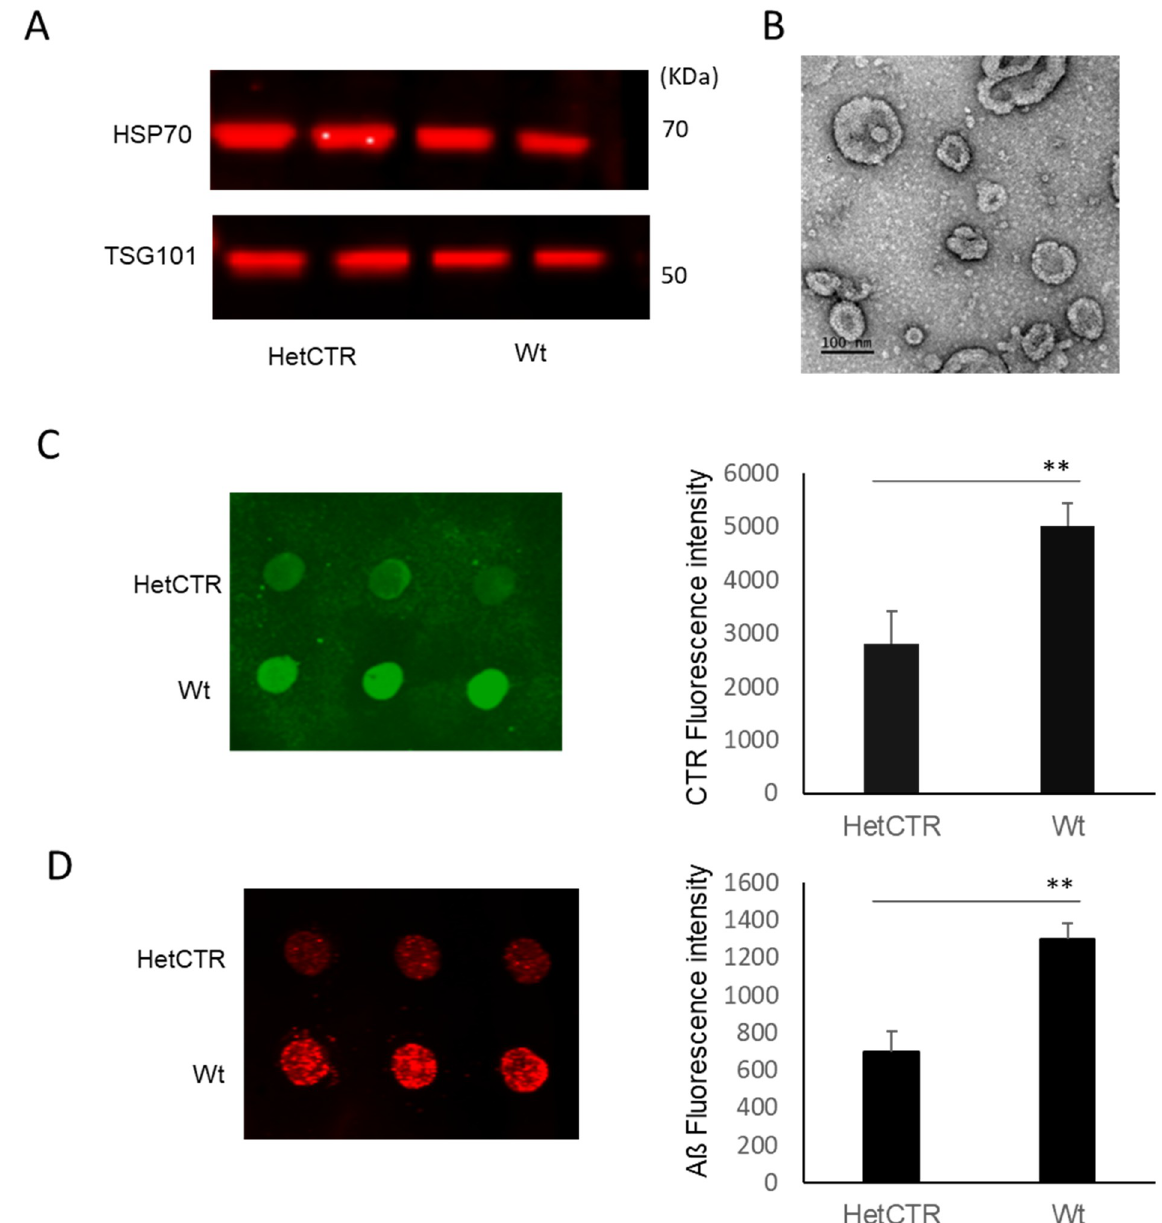
Fig 5. EVs from heterozygous AMY/calcitonin receptor (HetCTR) depleted mice and A β binding. A , Characterization of EVs from age- matched HetCTR mice brains and Wt mice using Western blot detection of EV markers, Hsp70, and TSG101. B , Transmission electron microscopy of EVs from brain of HetCTR mouse brain using a negative staining method. EVs appear as closed vesicles of 30–200 nm in diameter (Scale bar = 100 nm). C , Dot blot (left panel) showing greater abundance of CTR protein from EVs extracted from Wt mice compared to those from HetCTR mice. Histogram (right panel) showing the quantification of CTR from dot blots (Data presented as mean ± SEM, n = 5 mice each group. �� p < 0.01. D , Dot blots (left) and histograms (right) demonstrating increased A β binding to EVs from Wt mice compared to HetCTR mice following 30 min incubation the peptide. (A β levels are presented as the mean ± SEM, n = 5 mice each group, �� p < 0.01).